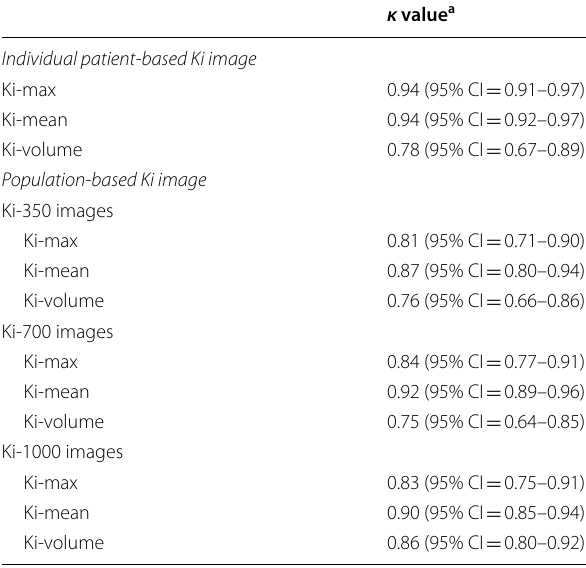
Ki-max, Maximum Ki; Ki-mean, Mean Ki; Ki-volume, Volume of Ki; and CI, Confidence